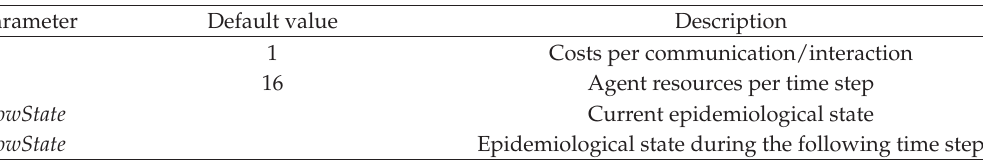
Table 4: Agent-related